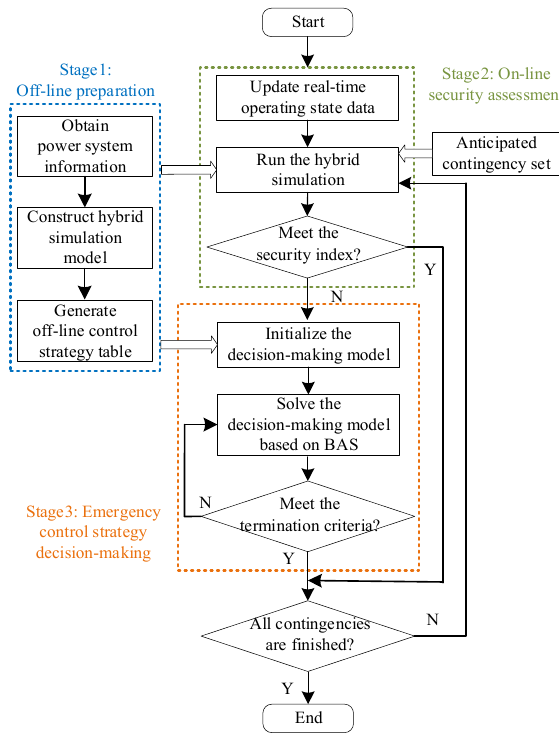
Figure 1. Procedure of the on-line pre-decision-making scheme.